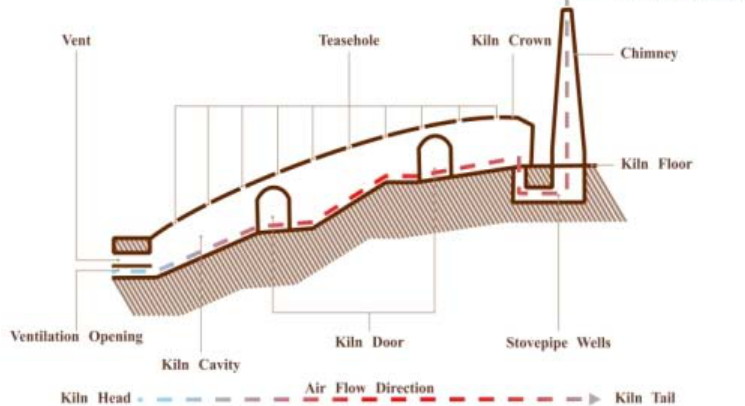
Figure 6. Internal Configuration of Dragon Kiln.